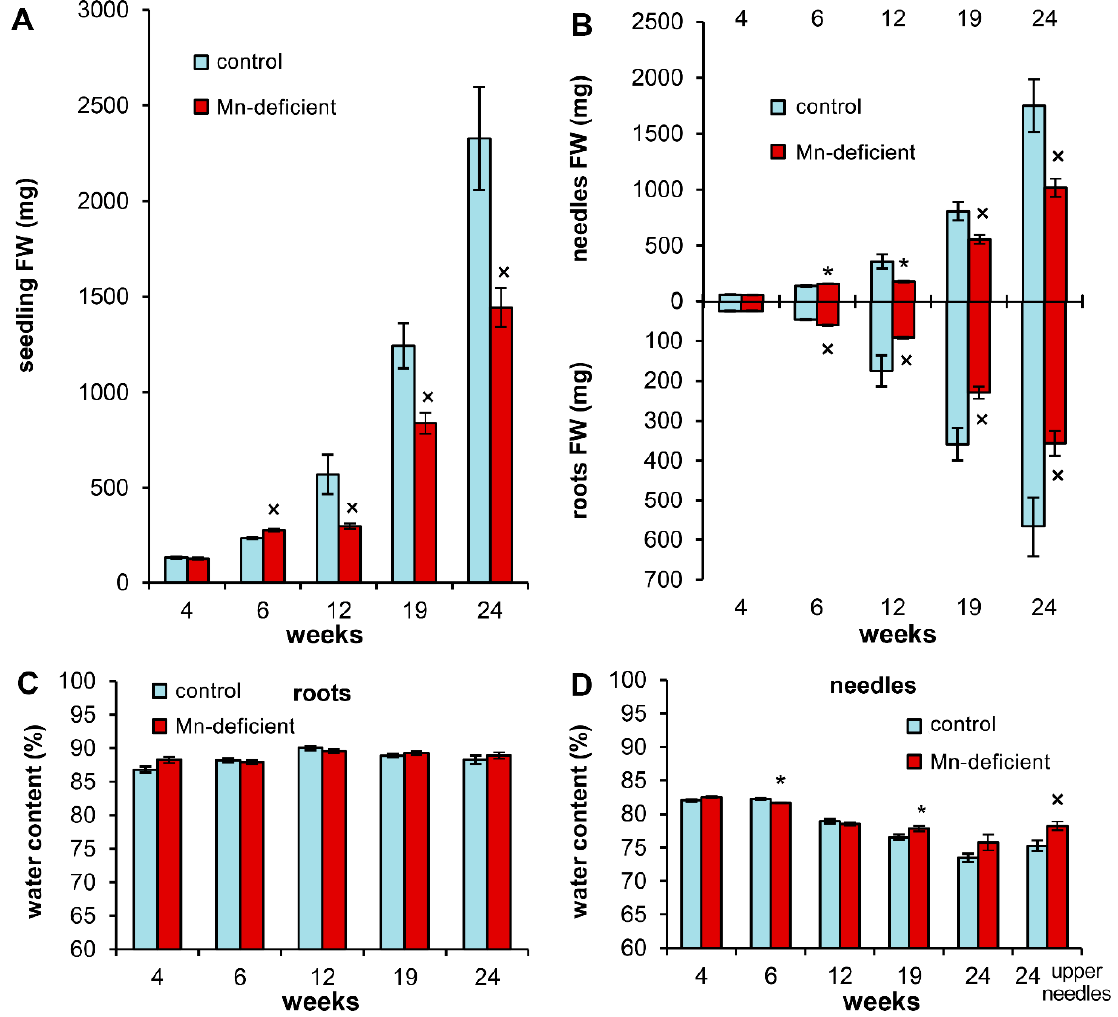
Figure 2. The fresh weight ( A , B ) and water content ( C , D ) in the organs of Scots pine seedlings during the experiment. Asterisks (*, for Student’s t test) or multiplication signs ( × , for Mann–Whitney rank sum test) denote significant differences at p < 0.05 between control and Mn-deficient plants at each separate time